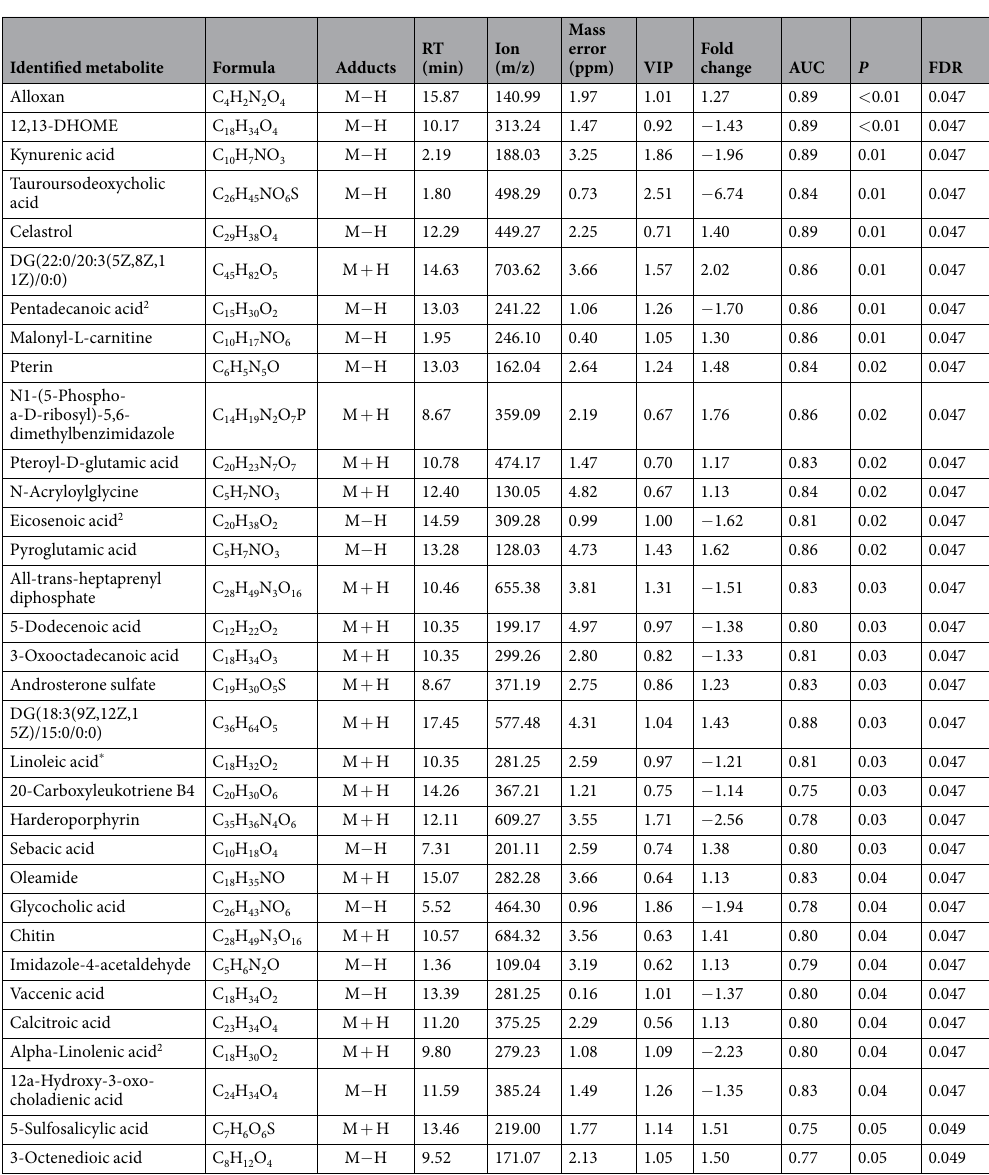
Table 3. Identification of candidate biomarkers for feed efficiency on ruminal fluid. RT, retention time; VIP, value of importance in projection; Fold changes comparing the greatest average daily gain steers ( n = 8) with the least average daily gain steers ( n = 8) on ruminal fluid metabolites; AUC, area under the curve; P , treatment effect result from t-test; FDR, false discovery rate p -adjustment. 2 Metabolites were quantified by liquid chromatogram tandem mass spectrometry using isotope dilution.